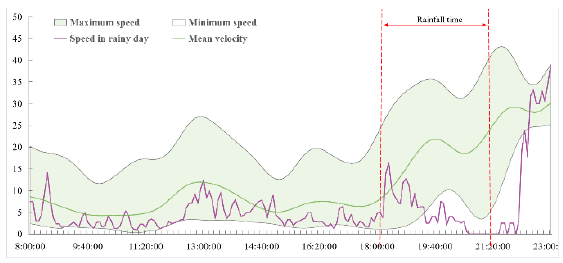
Figure 3 . Comparison of road speed (From 8 a.m. to 11 p.m.)